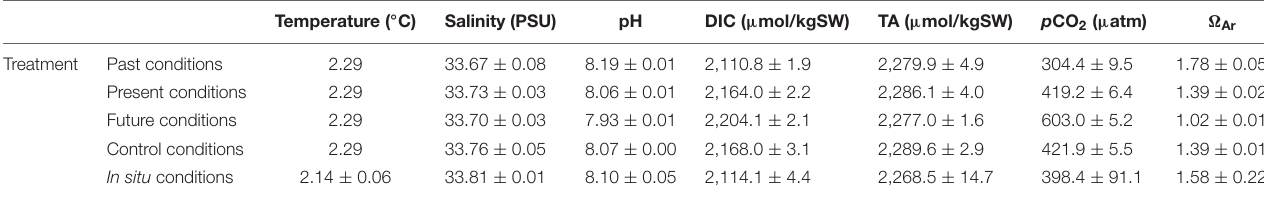
TABLE 1 | Mean ( ± SD) values of carbonate system parameters determined after 3 days of incubation for each experimental treatment. Temperature ( ◦